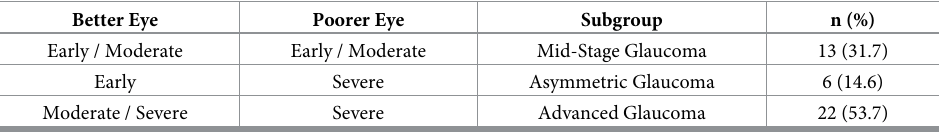
Table 2. Severities of visual field damage in both eyes of glaucoma subjects according to standard automated peri- metry results and subgroup classification. Better